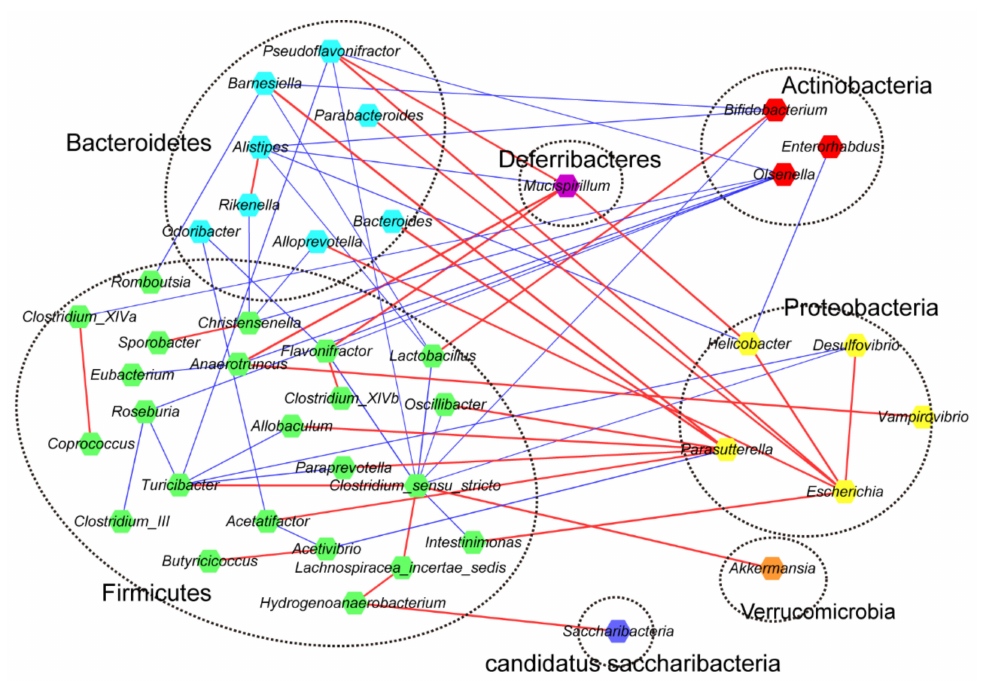
Figure 5. Correlation network generated using the SparCC algorithm. Each node in the Figure represents an ASV, the colors of the dots represent different microorganisms, and the microorganisms of the same phylum are in one area. The species are connected by straight lines. Red indicates positive correlation, blue indicates negative correlation, and the thickness of the line indicates the magnitude of the correlation.